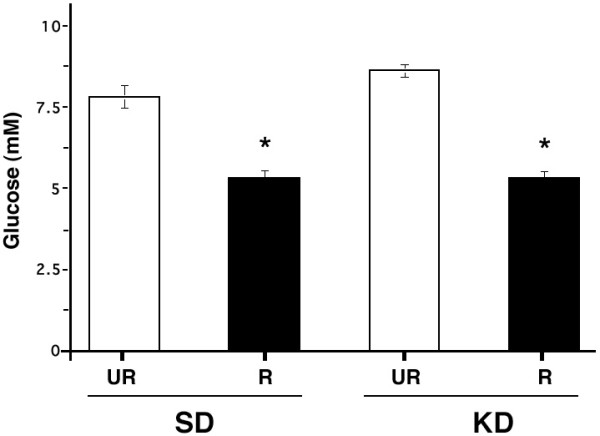
Influence of diet on plasma glucose levels in adult EL mice. Asterisks indicate that the plasma glucose levels were significantly lower (p < 0.001) in the R-fed groups than in their respective UR-fed groups. Other conditions are as in Figures 1 and 2.